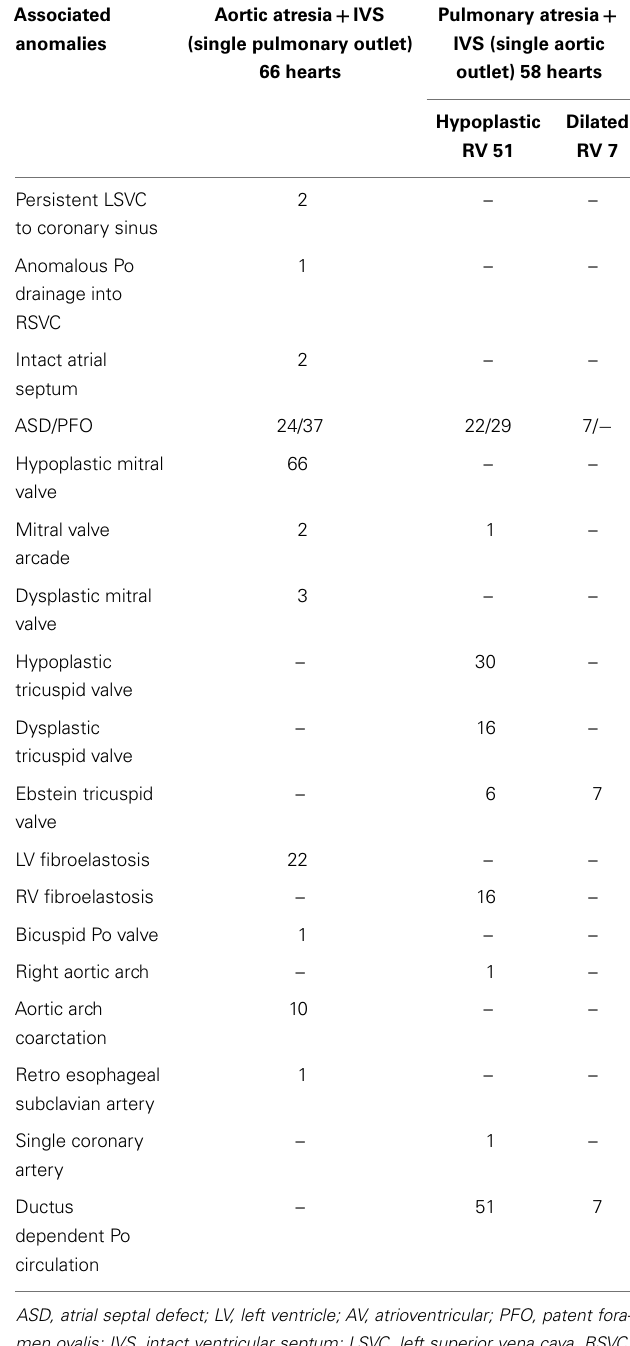
Table 8 | Hearts with biventricularAV connection and singleVA connection: mode ofVA connection .